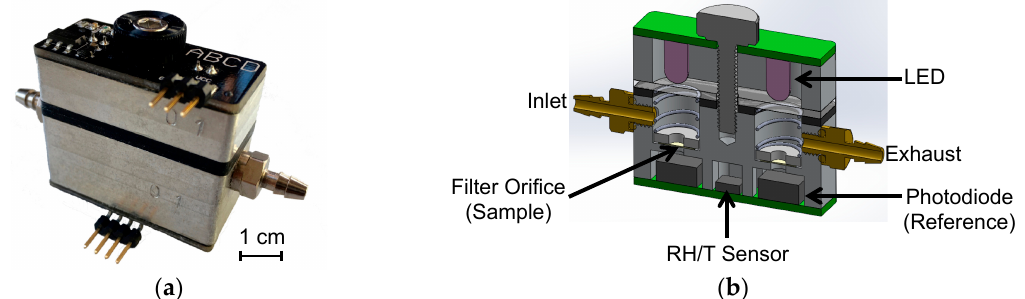
Figure 1. Aerosol Black Carbon Detector (ABCD): ( a ) Optical cell; ( b ) Section view of optical cell. Air is drawn into the cell with a rotary vane pump, and through two Teflon-coated glass-fiber